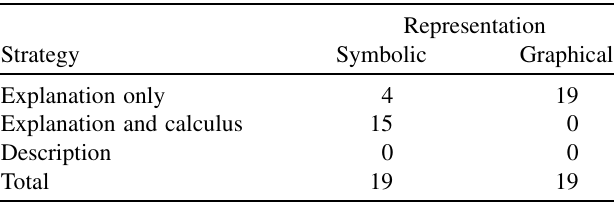
TABLE II. Strategy when solving for a quantitative solution from symbolic, graphical, and linguistic representations in kinematics. Strategy Symbolic Graphical Linguistic